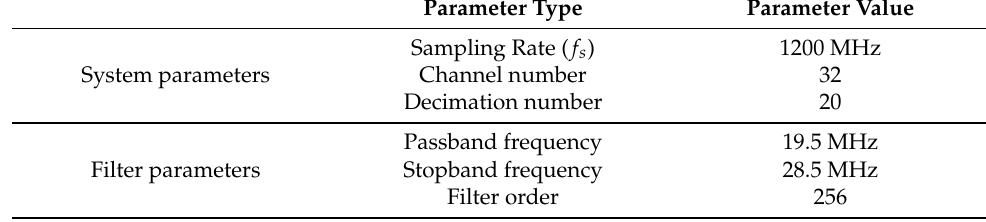
Table 2. System parameters and prototype filter parameters.